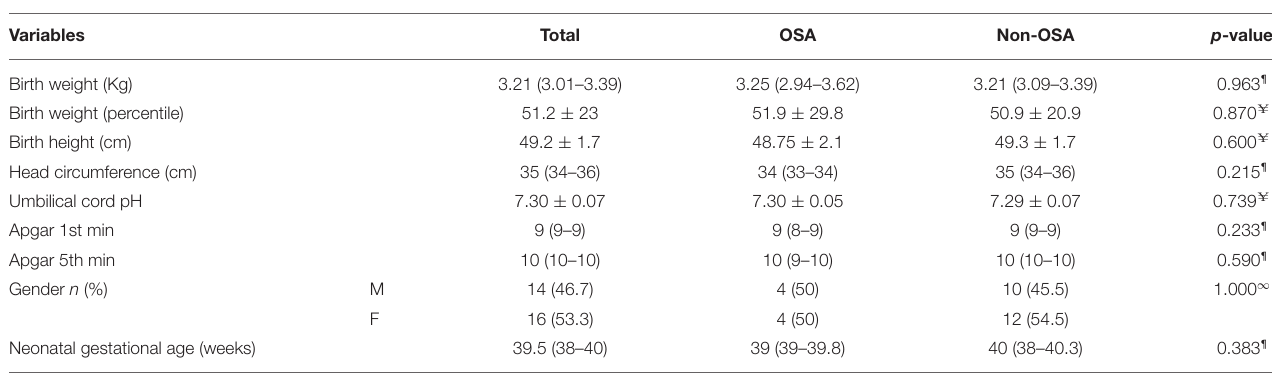
TABLE 4 | Neonatal characteristics in OSA and non-OSA